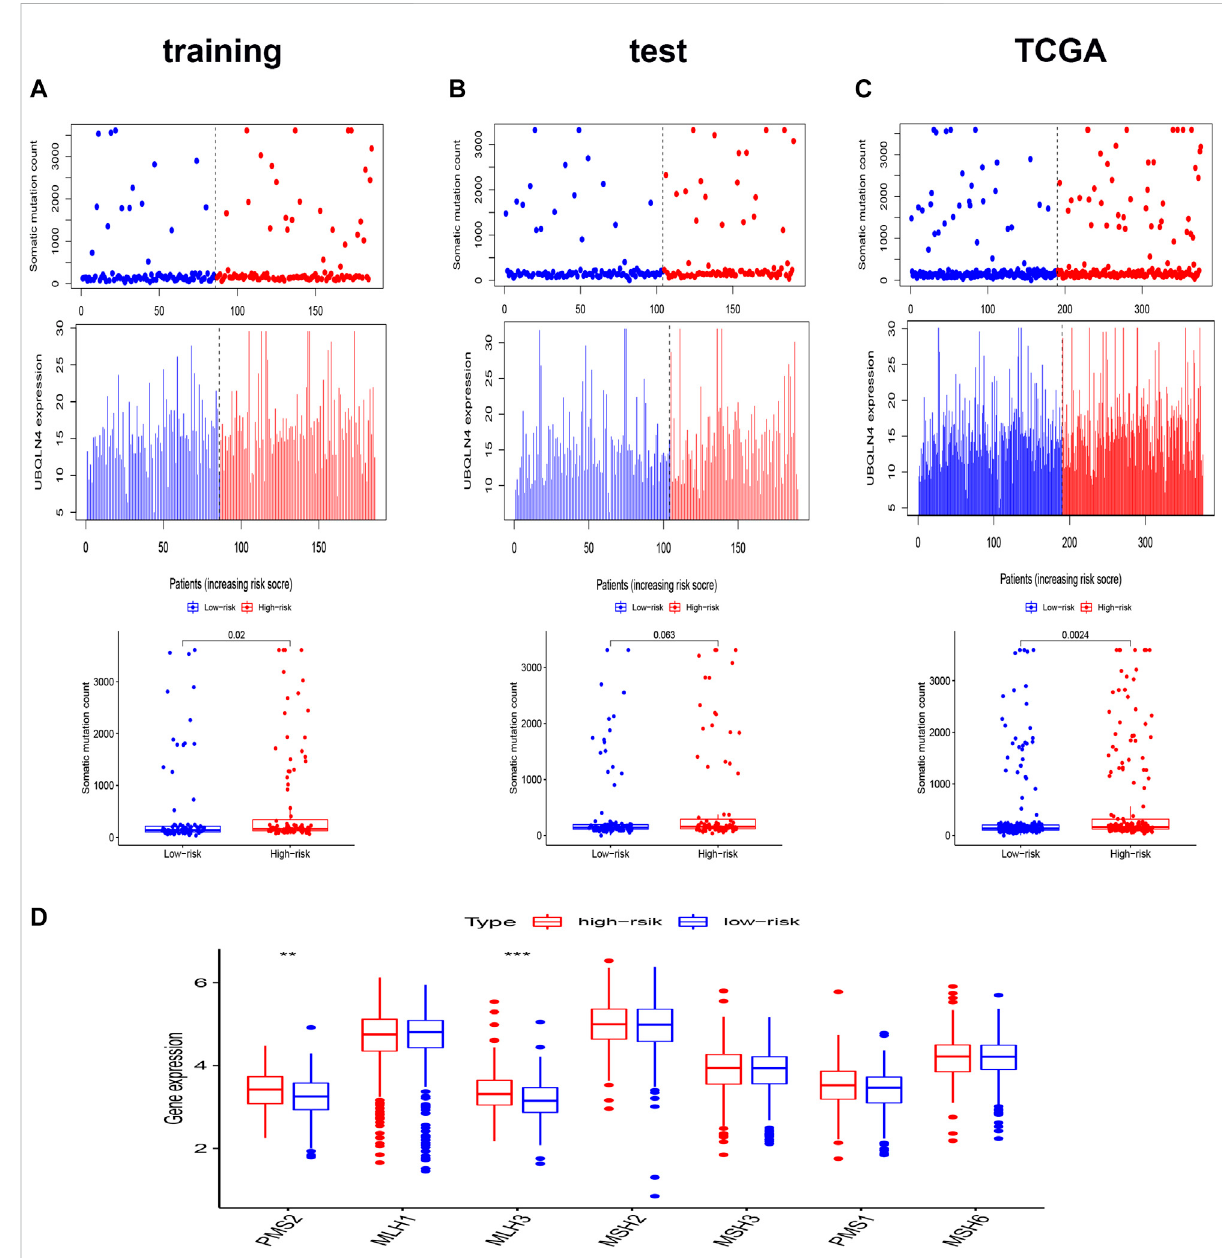
FIGURE 4 Relationship between the genomic instability-related AS signature and somatic mutation patterns of CRC patients. (A – C) The distribution of somaticmutationcountandUBQLN4expressionofthetrainingset (A) ,thetestset (B) ,andtheentireTCGAset (C) . (D)